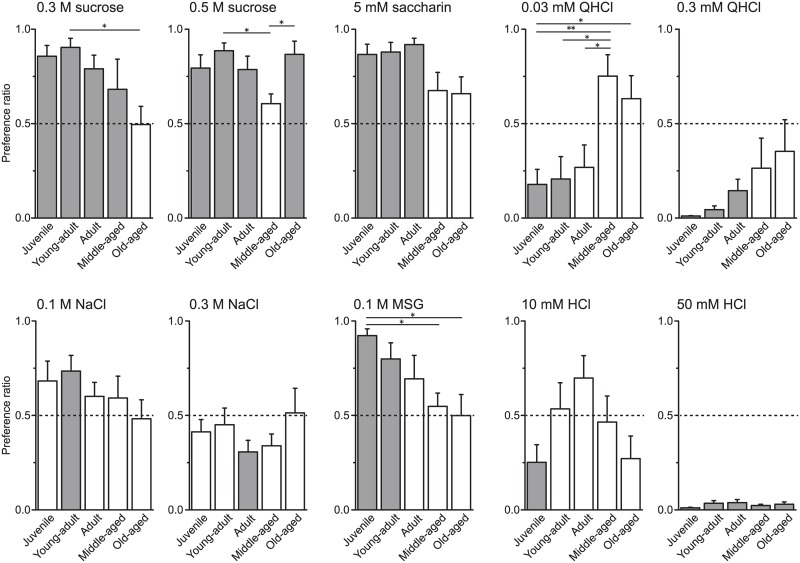
Age-related changes in taste preference using a 48-h two-bottle test.Mean preference ratios + SEM for each taste solution. The preference ratios for 0.3 M sucrose, 0.5 M sucrose, 0.03 mM QHCl, and 0.1 M MSG significantly differed among groups. *P < 0.05, young adult vs. old-aged (0.3 M sucrose), middle-aged vs. young adult and old-aged (0.5 M sucrose), juvenile vs. old-aged, middle-aged vs. young adult and adult (0.03 mM QHCl), juvenile vs. middle-aged and old-aged (0.1 M MSG); **P < 0.01, juvenile vs. middle-aged (0.03 mM QHCl). The dotted lines indicate chance level. The gray-colored bars indicate preference ratios significantly different from the chance level. The P value of the middle-aged group in the 0.03 mM QHCl experiment was 0.06.